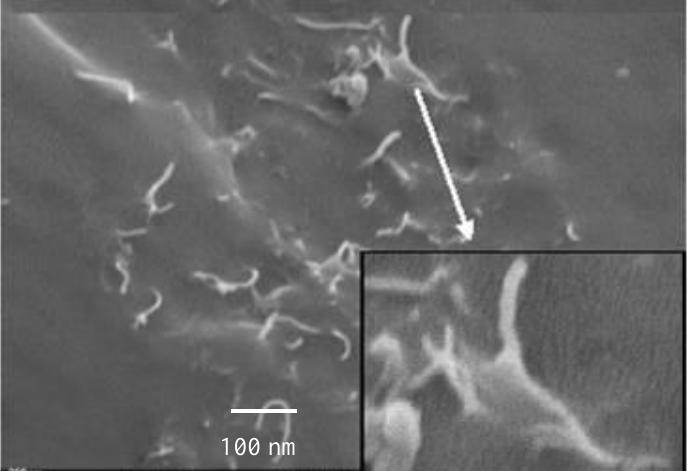
Figure 7. Isotactic polypropylene (PP) single walled CNT composite, Magnification 150,000×, for enlarged